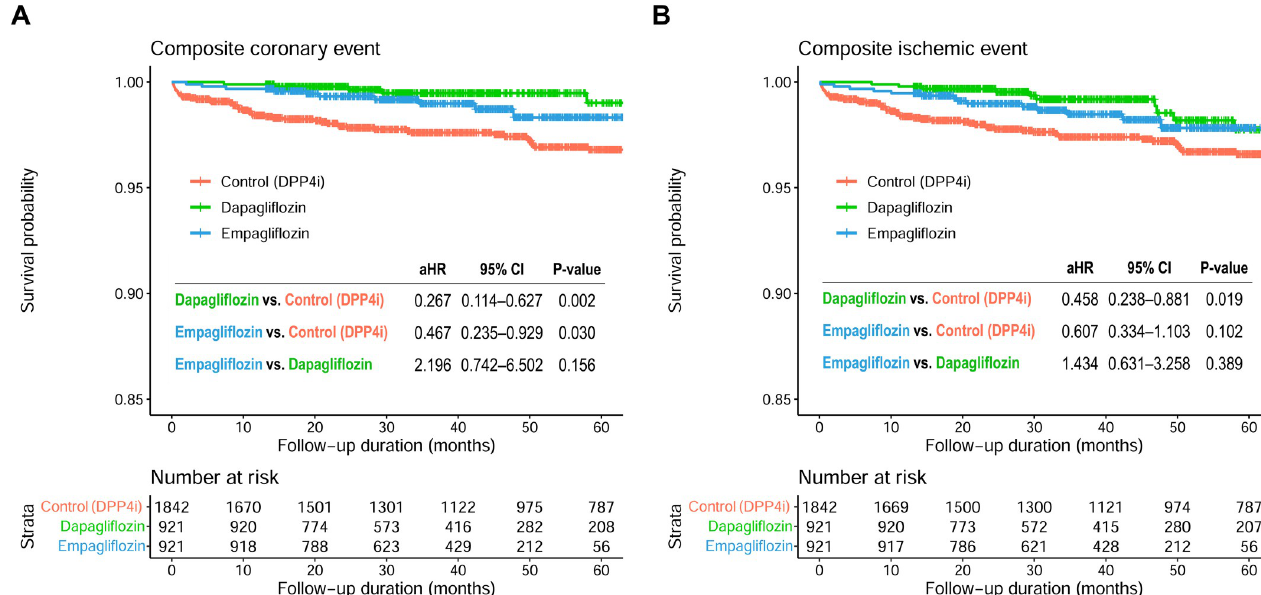
Fig 2. Event-free survival curves for atherosclerotic events. Kaplan-Meier curves comparing the risk of (A) composite coronary events and (B) composite ischemic events between the 3 groups. CI, confidence interval; HR, hazard ratio; SGLT2i, sodium-glucose co-transporter 2 inhibitor.